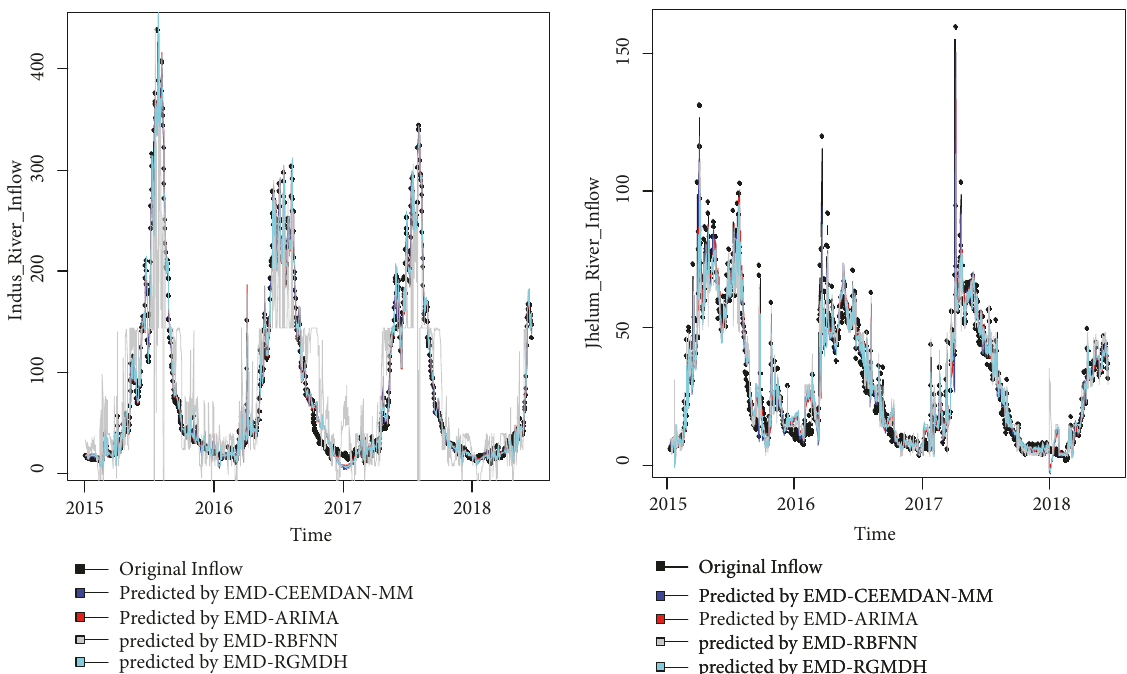
Figure 8: Prediction results of Indus and Jhelum rivers inflow using proposed EMD-CEEMDAN-MM with comparison to other EMD based denoised and predicted models.